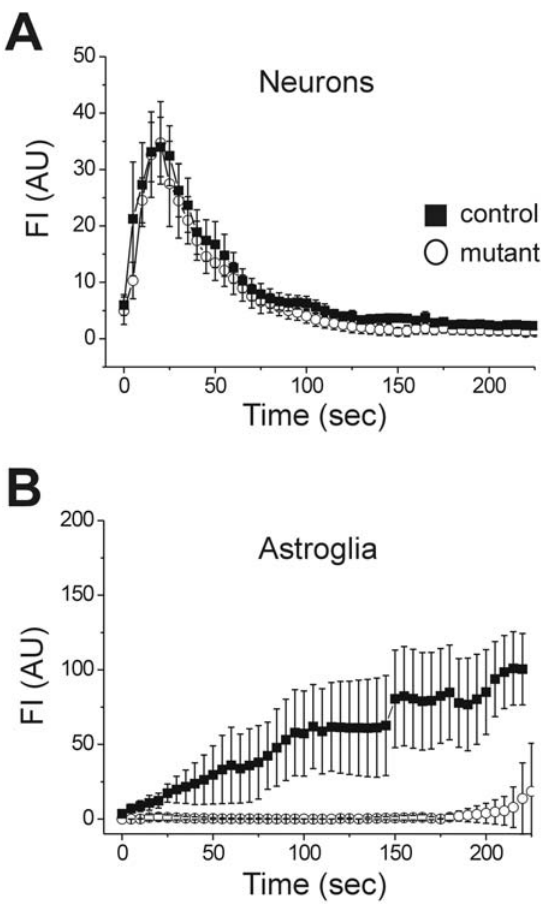
Figure 5. Mutant astroglial NOS activity is dependent on Ca 2 + release from internal stores. The slices were incubated for 45 minutes in thapsigargin (5 m M) to deplete the Ca 2 + internal stores. Single cells FI is plotted over time of illumination, and data are expressed as mean 6 SEM. (A) Putative neurons identified by punctate DAF-2DA fluorescence were not affected by thapsigargin in either mutant (closed squares, 32 cells, 6 slices) or control (open circles, n=27 cells, 7 slices) mice. (B) Astroglial diffuse fluorescence displayed normal kinetics in control, thapsigargin-treated slices (n=19 cells, 7 slices), but was almost completely abolished in slices from mutant mice (n=2 cells, 6 slices).